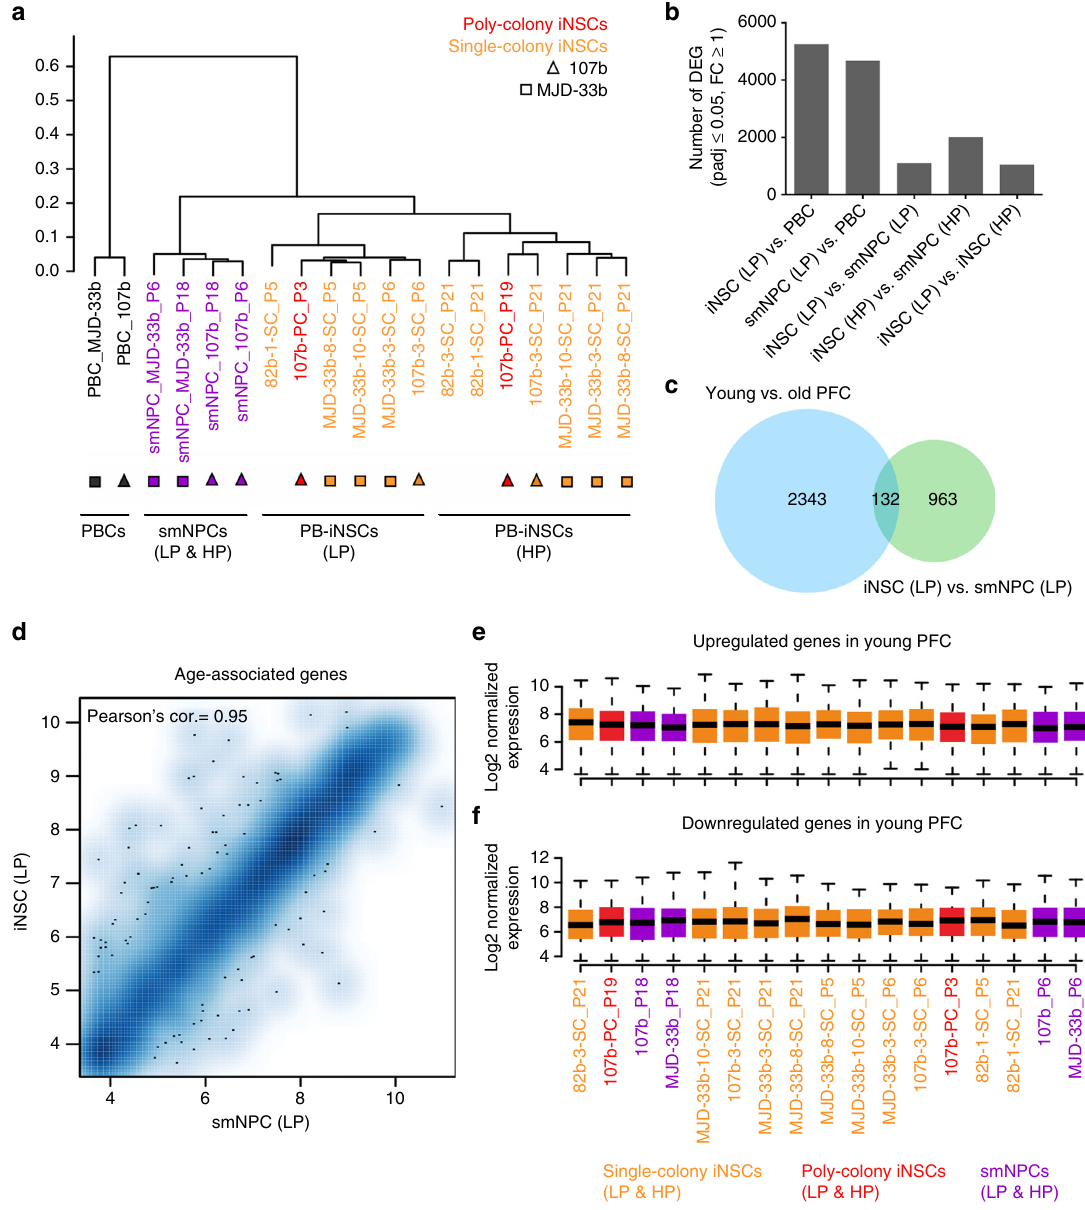
Fig. 6 Age-associated transcriptional signatures of iNSCs and PSC-derived NPCs. a Clustering of global transcriptional pro fi les of PBCs, iNSCs, and isogenic smNPCs at low ( P ≤ 6) and high ( P ≥ 18) passages. b Number of DEGs between different cell populations ( q -value ≤ 0.05, absolute fold-change ≥ 1). c RNA seq data of post-mortem PFC tissues revealed 2,475 age-associated genes differentially expressed between young (<49 years of age) and old ( ≥ 49 years of age) brain samples. The Venn diagram shows that genes differentially expressed in low passage iNSCs vs. iPSC-derived low passage smNPCs include only 132 out of 2,475 genes (5.3%) differentially expressed in young vs. old PFC. d Scatter plot analysis of age-associated genes showing little difference between low passage iNSCs and smNPCs. e , f Expression level distribution of the 470 age-associated DEGs that are shared by all 3 comparisons (young vs. old PFC as well as low passage iNSCs and smNPCs vs. PBCs) shows no difference across low and high passage smNPCs and iNSCs. In contrast, gene expression level distribution across the young and old PFC samples shows a clear separation (Supplementary Fig. 12e, f) between the two groups. Data are shown for genes with higher expression levels in young ( e ) and higher expression levels in old ( f ) PFC samples. Box plots display the median (center line), the 25th and 75th percentile (upper and lower box, respectively) and 1.5-times the interquartile range from the box (whiskers). Data points outside this region are not